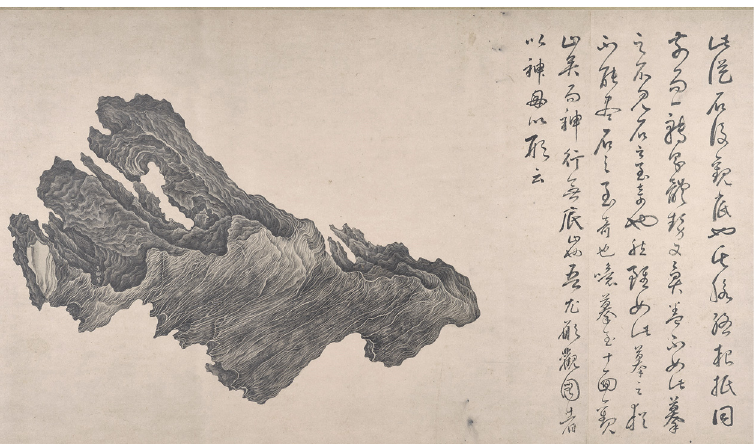
Figure 2. Wu Bin, Ten Views of a Lingbi Rock (detail), the tenth view with the painter’s signature. Photo: Courtesy of Poly Art Museum, Beijing (Baoli yishu yanjiuyuan 2020).